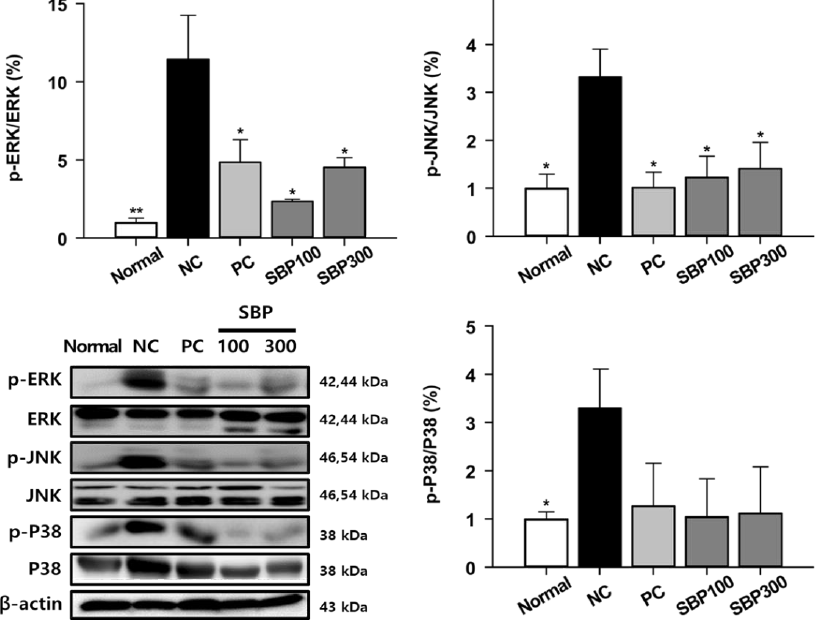
Figure 4. The expression of inflammatory proteins in the lung tissue from OVA-treated mice. Normal, normal control; NC, negative control; PC, positive control; SBP100, SBP at 100 mg/kg; SBP300, SBP